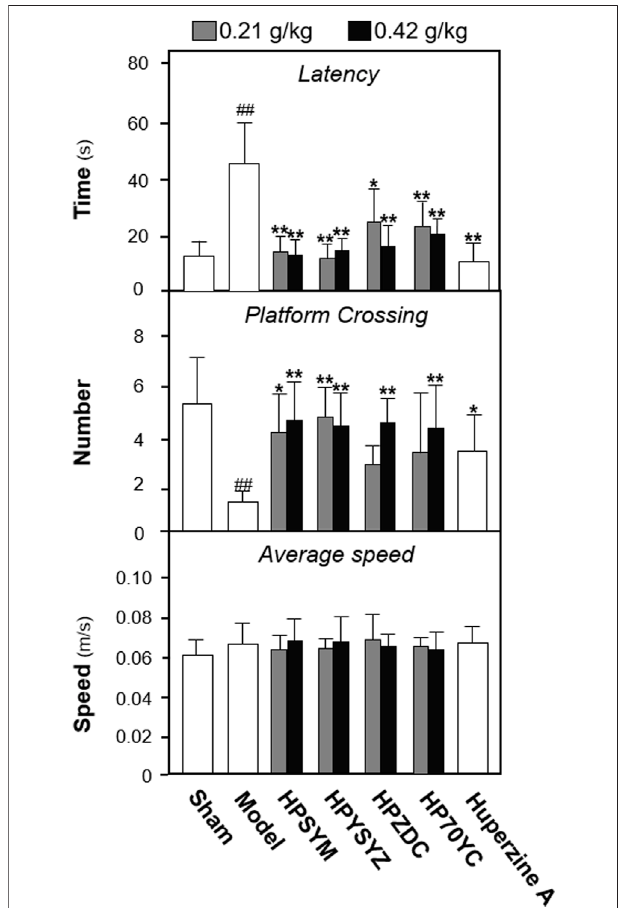
FIGURE 1 | Extracts of succinum ameliorated learning and memory impairment on carotid artery ligation rats. The effect of succinum extracts on the latency time, platform crossing number, and average speed of carotid artery ligation rats. Values are expressed as mean ± SEM ( n = 8). Comparisons between groups were carried out by a one-way ANOVA followed by a post hoc Bonferroni test. ## p < 0.01 (compared with the sham control group), * p < 0.05, and ** p < 0.01 (compared with the carotid artery ligation model